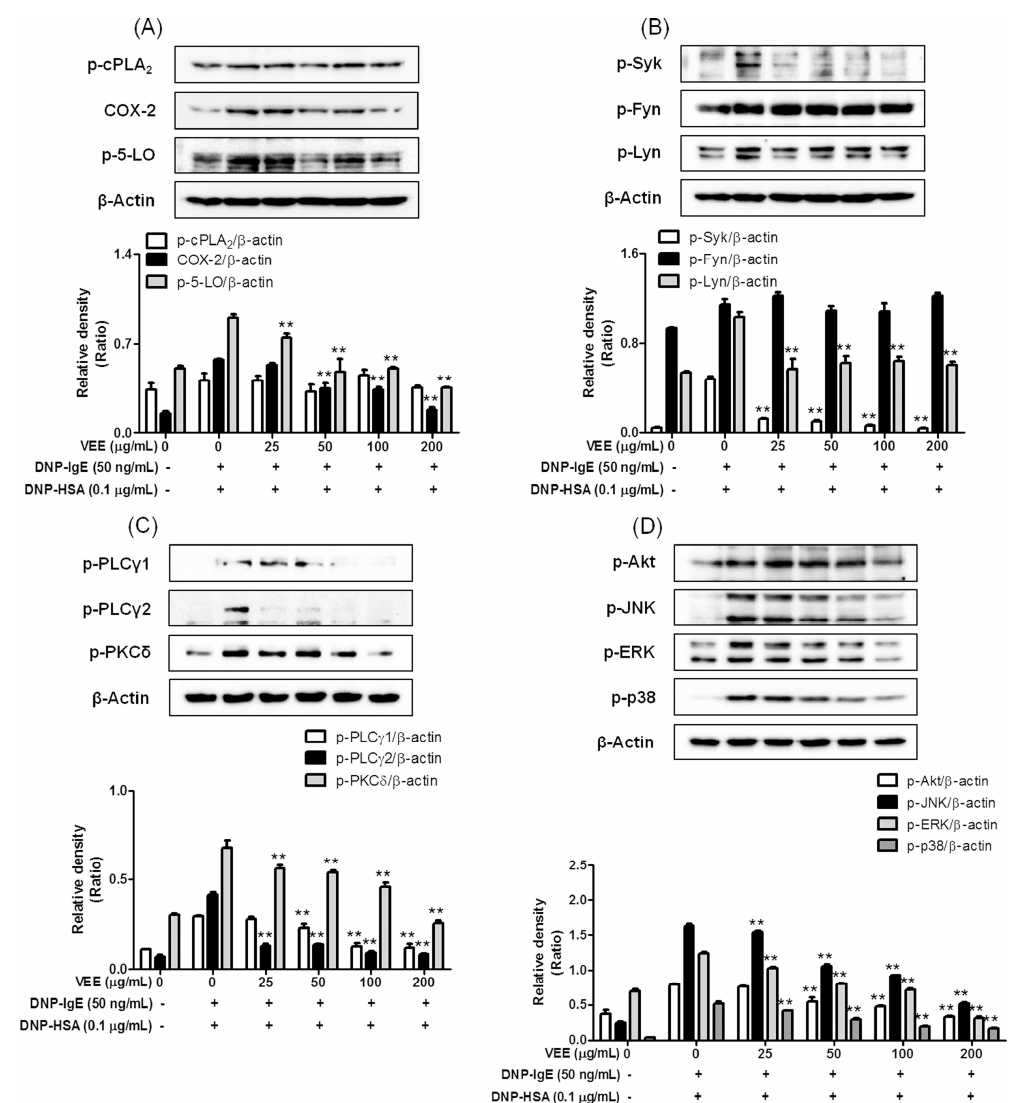
Figure 3. Effects of VEE on activation of the Fc ε RI and arachidonate cascades. RBL-2H3 cells were seeded in a 6-well plate (5 × 10 5 cells/well) in MEM- α with 10% FBS at 37 °C overnight and further incubated with DNP-IgE for 24 h. IgE-sensitized RBL-2H3 cells were preincubated with VEE for 1 h and then stimulated with antigen for 4 h or 10 min. The cells were washed with 1× DPBS and lysed with a cell lysis buffer. The expression of p-cPLA 2 , COX-2, p-5-LO, p-Syk, p-Fyn, p-Lyn, p-PLC γ 1, p-PLC γ 2, p-PKC δ , p-Akt, p-JNK, p-ERK, p-p38, or β -actin was determined as described in the Materials and Methods section. Similar results were obtained in three independent experiments. ** p < 0.01 versus DNP-HSA-treated group. ( A ) p-cPLA 2 , p-5-LO, and COX-2; ( B ) p-Syk, p-Fyn, and